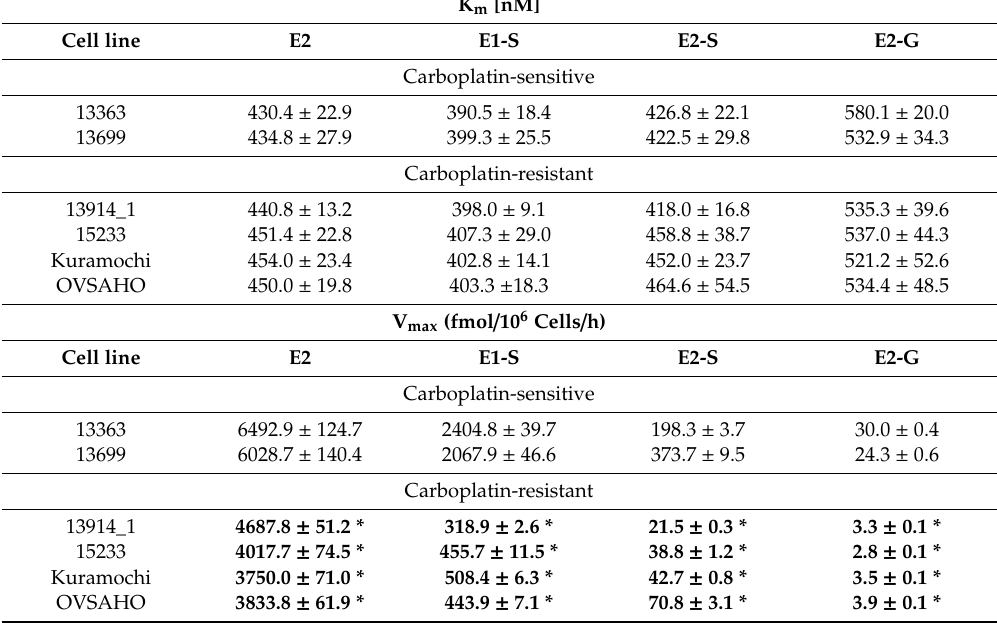
Table 2. Kinetic parameters of E1 metabolism by the investigated HGSOC cells. K m and V max values were calculated using GraphPad Prism 6.0 software following the incubation of the cell lines with increasing concentrations of E1 (0–2000 nM) as a hormone precursor for 48 h. All data are presented as the means ± SD of three independent experiments. Values in bold and marked with an asterisk ( * ) are significantly di ff erent as compared with both carboplatin-sensitive cell lines 13363 and 13699 ( p <